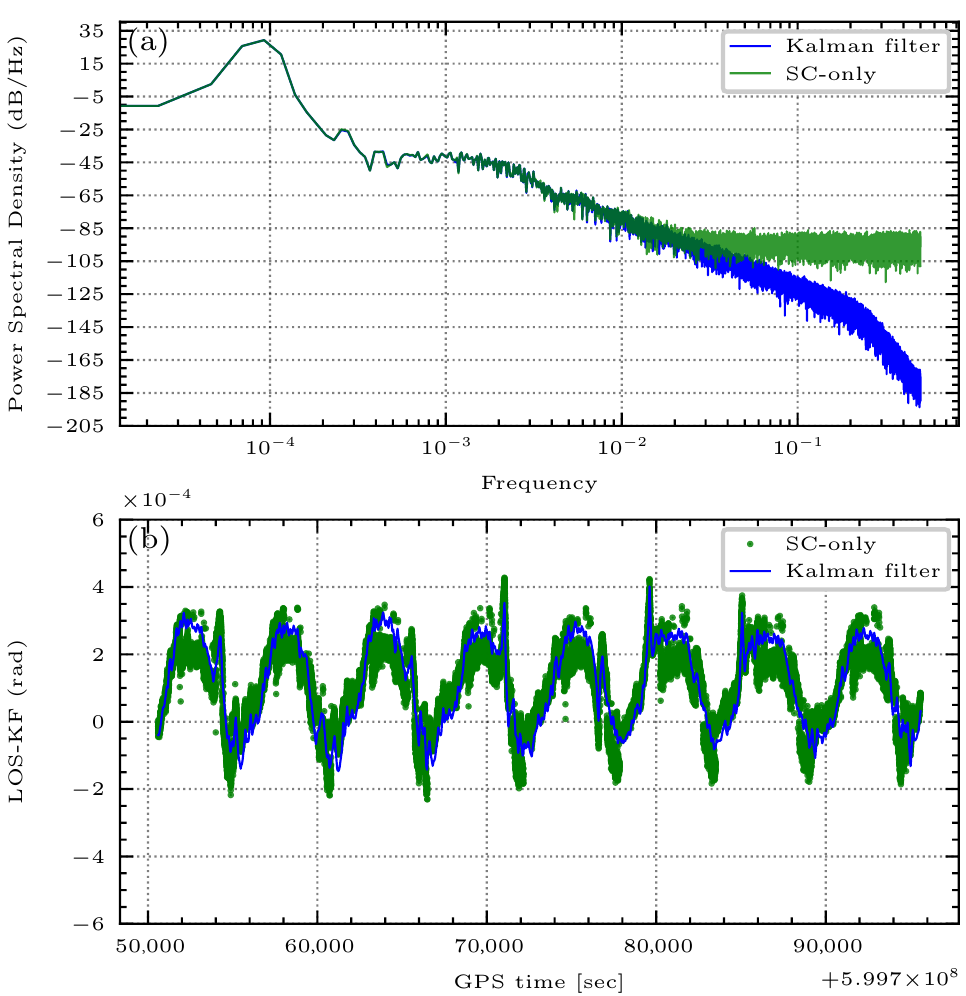
Figure 6. Comparisons of derived attitude between SC-only strategy and Kalman filter strategy, on 3 January 2019 for GRACE-FO Sat-D ( a ) plots the PSDs of quaternion component q . z obtained from the Kalman filter and SC-only strategy, respectively. In particular, ( b ) is carried out in the frame of ’LOS-KF’, denoting the inter-satellite pointing variation, see Section